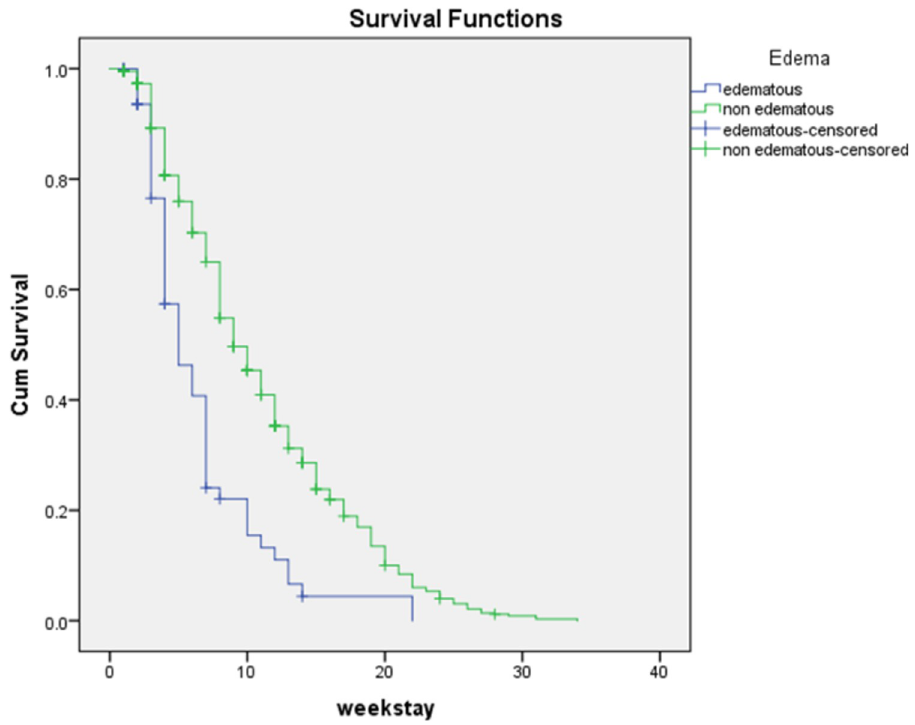
Fig 3. Comparative Kaplan Meir survival function for SAM Children with edema and without edema, from 2013 to 2016 in Dire Dawa, Ethiopia (Log Rank chi-square = 35.760, p-value < 0.001).